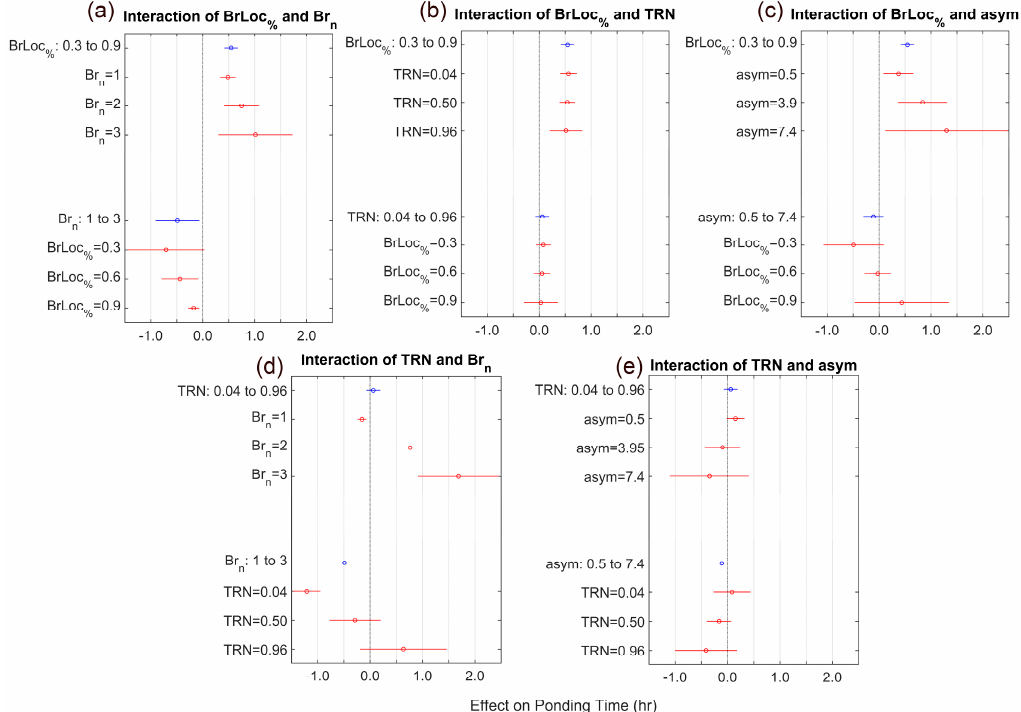
Figure 9. Estimated effects on ponding time of keeping one predictor fixed (percentage of the total storm period that has occurred at the start of the heaviest burst—BrLoc % , number of bursts—Br n , hyetograph triangularity—TRN, asymmetry of the storm—asym) while varying the other. The average effect is shown as a circle, while the horizontal bars are showing the confidence interval for the estimated effect. The blue symbols represent the overall average effect obtained by changing one predictor independently from the other, while the red ones represent the average effect achieved by changing one predictor over different values of the other one.